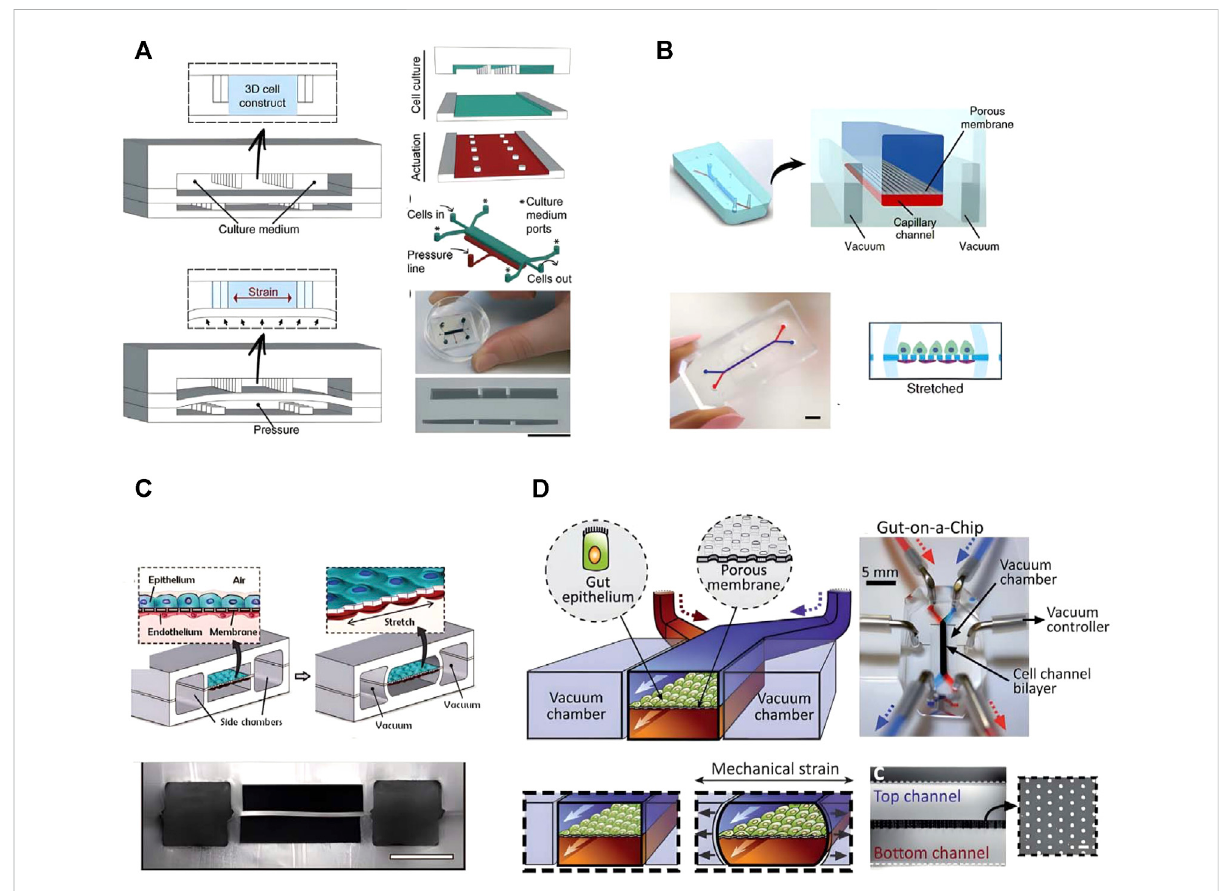
FIGURE 1 The representative chips of Organ-on-a-chip. (A) Heart on a chip (adapted and modi fi ed from Marsano et al., 2016). (B) a Glomerulus Chip (adaptedandmodi fi edfromMusahetal.,2018). (C) Lungchip(adaptedandmodi fi edfromHuhetal.,2010). (D) Intestinalchip(adaptedandmodi fi ed from Kim et al.,